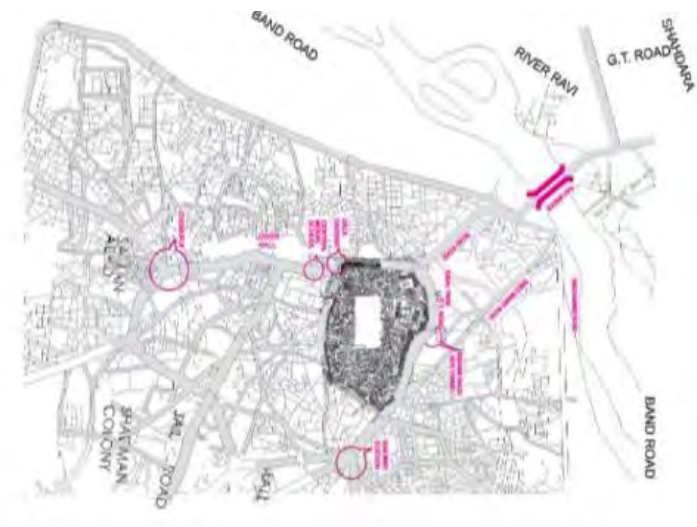
Figure 2. Master Plan Lahore Fort